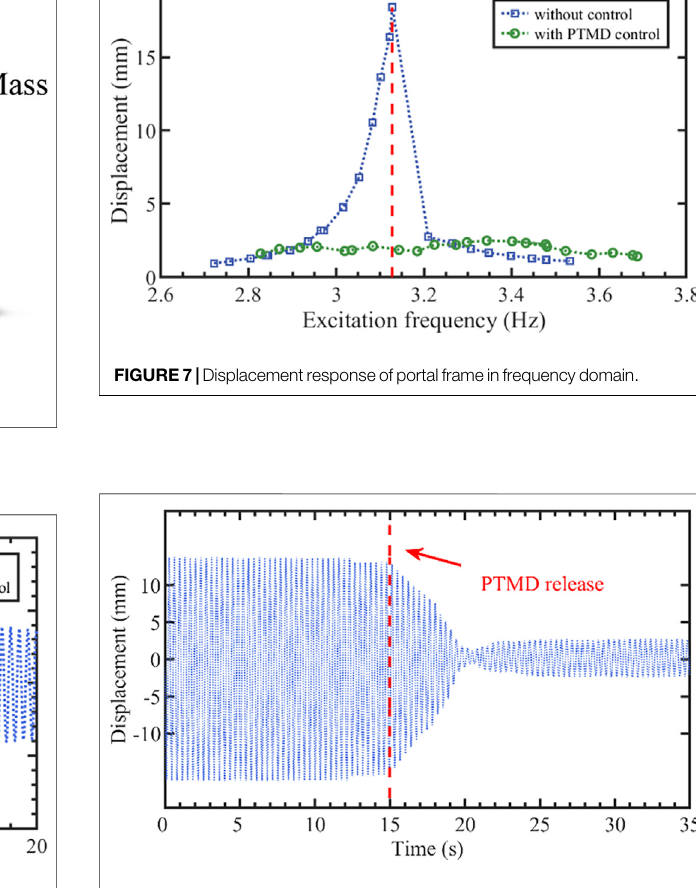
FIGURE 8 | Displacement response of forced vibration with PTMD release.